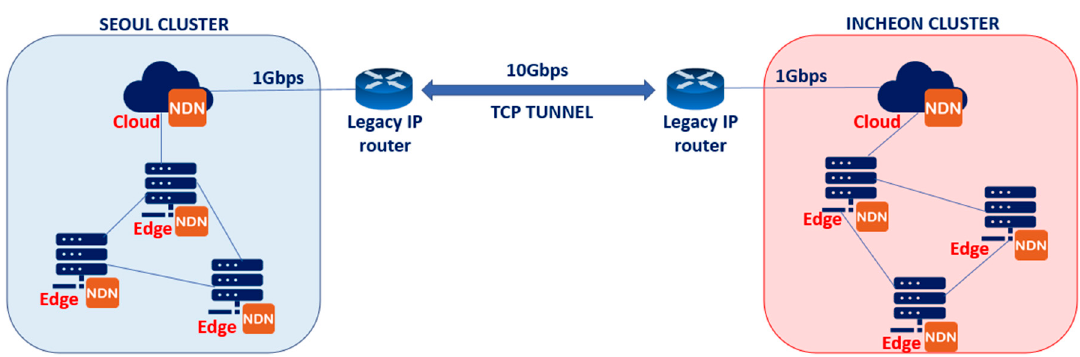
Figure 4. NDN over KubeEdge general network architecture in two regions.